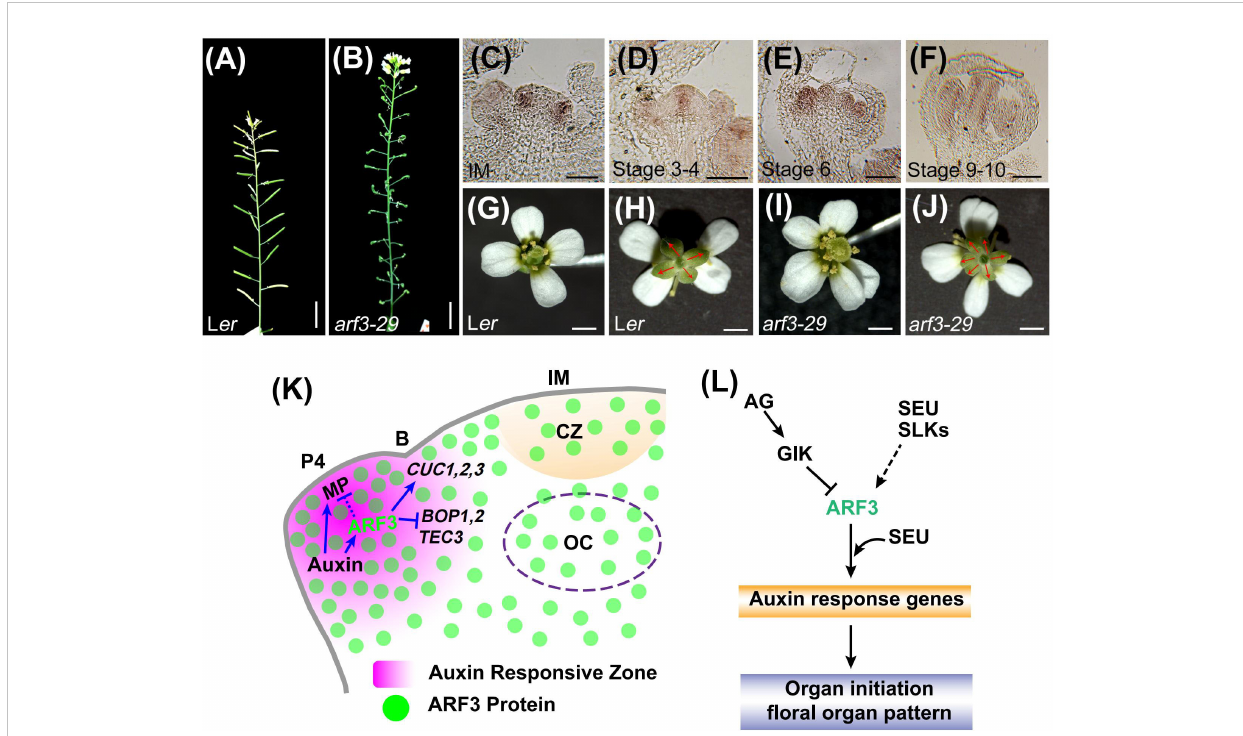
FIGURE 3 ARF3 controls phyllotaxy and fl oral organ patterning cell autonomously. (A, B) , Representative images of in fl orescence stems for the indicated genotypes (from Zhang et al., 2022, provided by Dr. Ke Zhang). Scale bars = 1 cm. (C – F) , ARF3 expression in IM (C) and FM at stage 3 (D) , stage 6 (E) and stage 9 – 10 (F) examined by in situ hybridization (from Zhang et al., 2022, provided by Dr. Ke Zhang). Bars = 50 m m. (G – J) , The number of fl oral organs in the indicated genotypes. Compared with Ler (G, H) , arf3 fl owers have more sepals, petals and stamens (I, J) . The sepals are marked by red arrows. Bars = 1 mm. (K) , (A) model of phyllotactic patterning control by ARF3. Auxin promotes ARF3 in fl oral primordia, where it regulates meristem – organ boundary-speci fi c genes ( CUC1 – 3 , BOP1 – 2 , and TEC3 ) and MP in a cell-autonomous manner. Figures adapted from (Zhang et al., 2022). P4, primordia of fl ower buds at different developmental stages; (B) , meristem – organ boundary. Blue solid arrows indicate direct and indirect positive regulation. Blue solid and dashed block lines indicate direct and indirect negative regulation, respectively. (L) , A model of fl oral organ patterning control by ARF3. ARF3 cooperates with SEU to control organ initiation and fl oral organ pattern by regulating auxin response genes, and ARF3 is inhibited by GIK directly and promoted by SEU and SLKs. Solid and dashed arrow indicates positive regulation. Block lines indicate negative